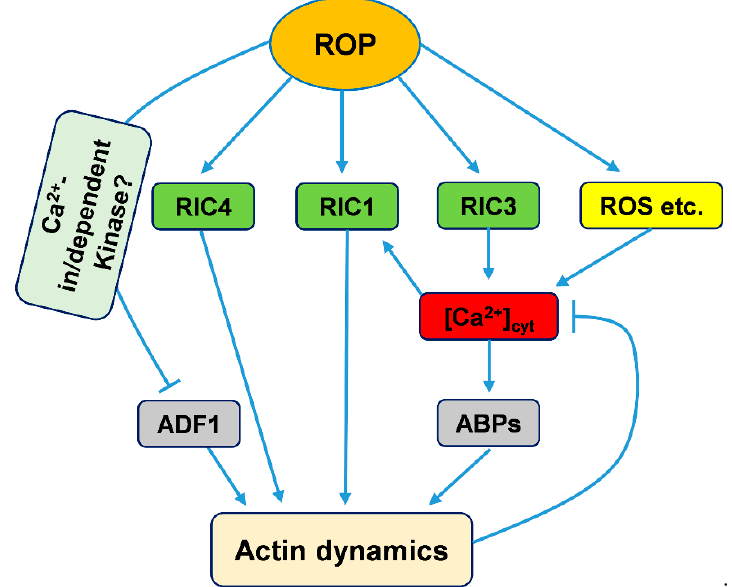
Figure 2. Working model to explain ROP signaling pathway mediation of actin cytoskeleton regulation by calcium in pollen tubes. ROP, ROP GTPases; RIC, ROP-interactive and CRIB motif-containing protein; ROS, Reactive oxygen species .